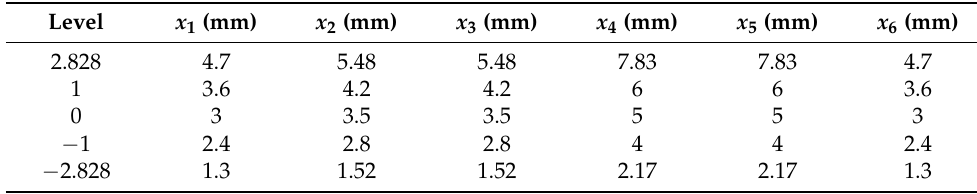
Table 5. Levels of design variables of the solid